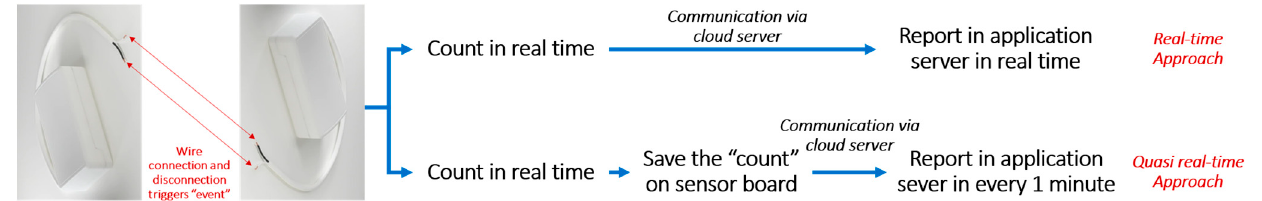
Figure 10. Comparison of two sensor configuration methods.